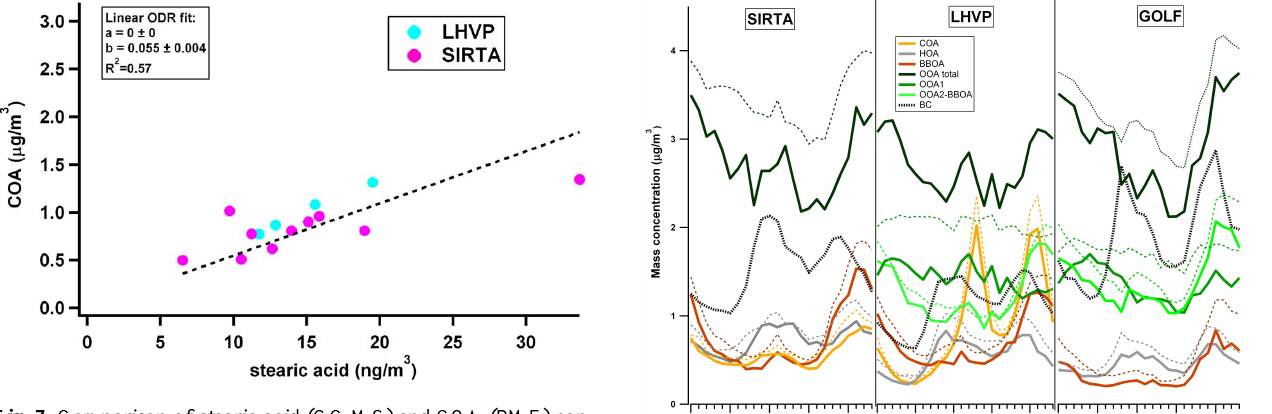
Fig. 7. Comparison of stearic acid (GC-MS) and COA (PMF) con- centrations.